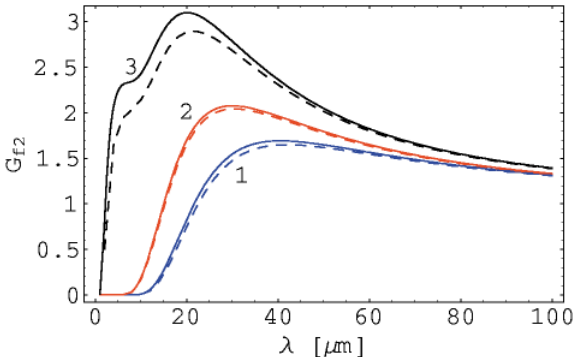
FIG. 3. (Color) BC2 gain G f 2 of the density modulation as a function of the modulation wavelength at the entrance of BC2 for (1) s d (cid:1) 3 3 10 2 5 , g´ 0 (cid:1) 1 m m (in blue); (2) s d (cid:1) 3 3 10 2 5 , g´ 0 (cid:1) 0 m m (in red); (3) s d (cid:1) 3 3 10 2 6 , g´ 0 (cid:1) 1 m m (in black). Solid curves are calculated from Eq. (38) and dashed curves are numerical solutions of the integral equation found in Ref. [8].